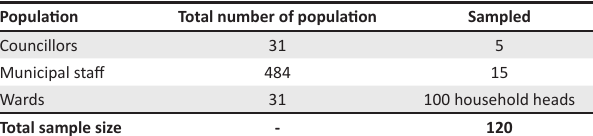
TABLE 1: Total number of population sampled.